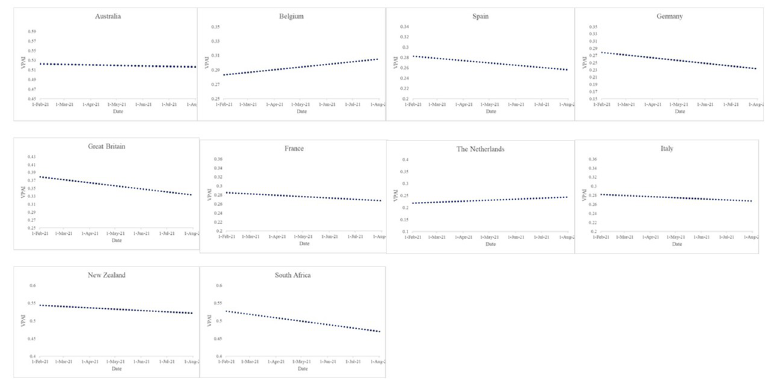
Fig 6. Trend in the positive attitude for each of the ten countries. Source: Authors’